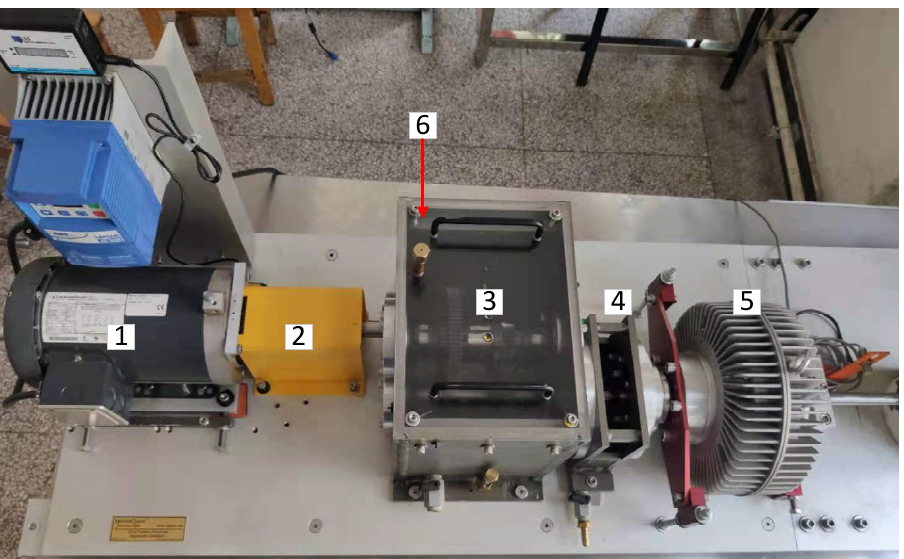
Figure 9. Wind turbine drivetrain diagnostics simulator (WTDS). 1—variable speed drive; 2—torque transducer and en-